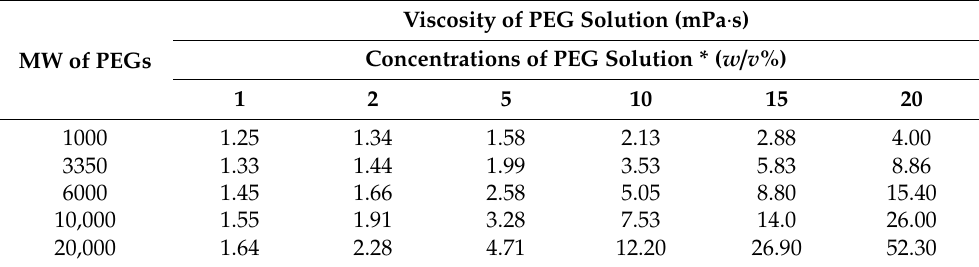
Table 1. Measured macroviscosities of the PEG solutions in the FCS bu ff er. Viscosity of PEG Solution (mPa · s) Concentrations of PEG Solution * ( w / v %) MW of PEGs 1 2 5